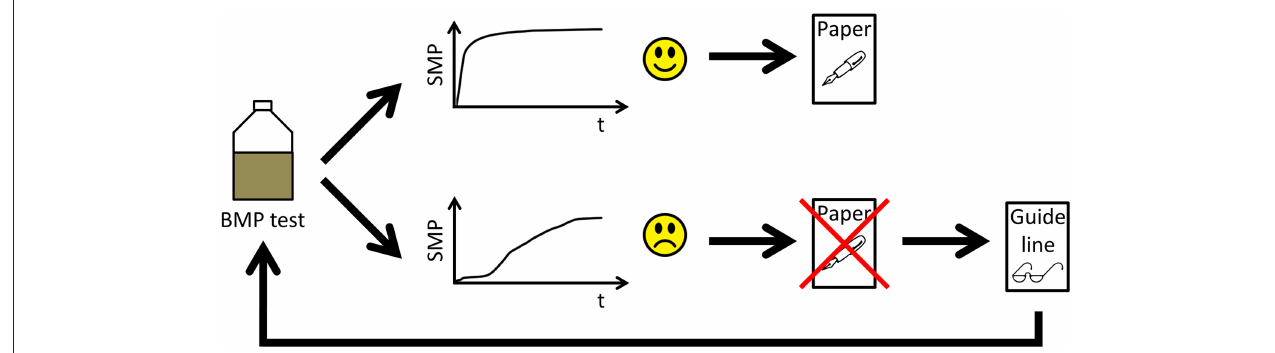
FIGURE 1 | Graphical representation of the hypothesized method.